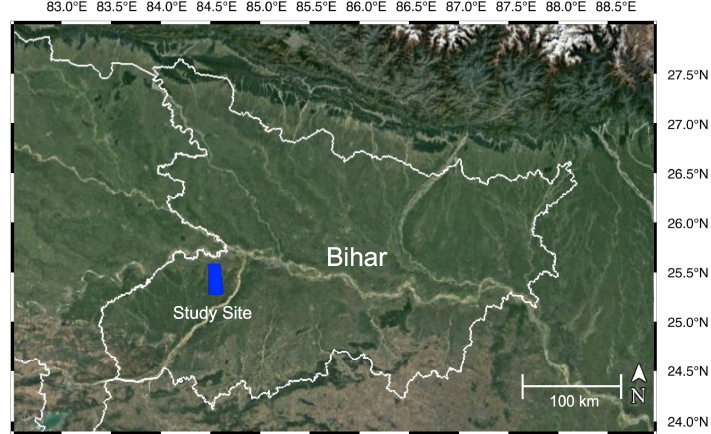
Figure 1. Study region in Arrah district, Bihar, India. The study region extent is highlighted by the dark blue rectangle. The state boundary of Bihar is highlighted in white.